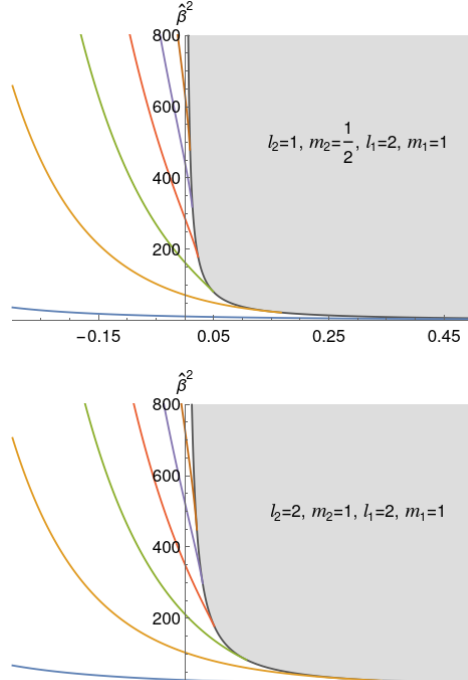
Figure 3 . Spectrum of the first six non-BPS families of eigenvalues parameters given by (5.66) and a few choices of ‘ is defined as in figure